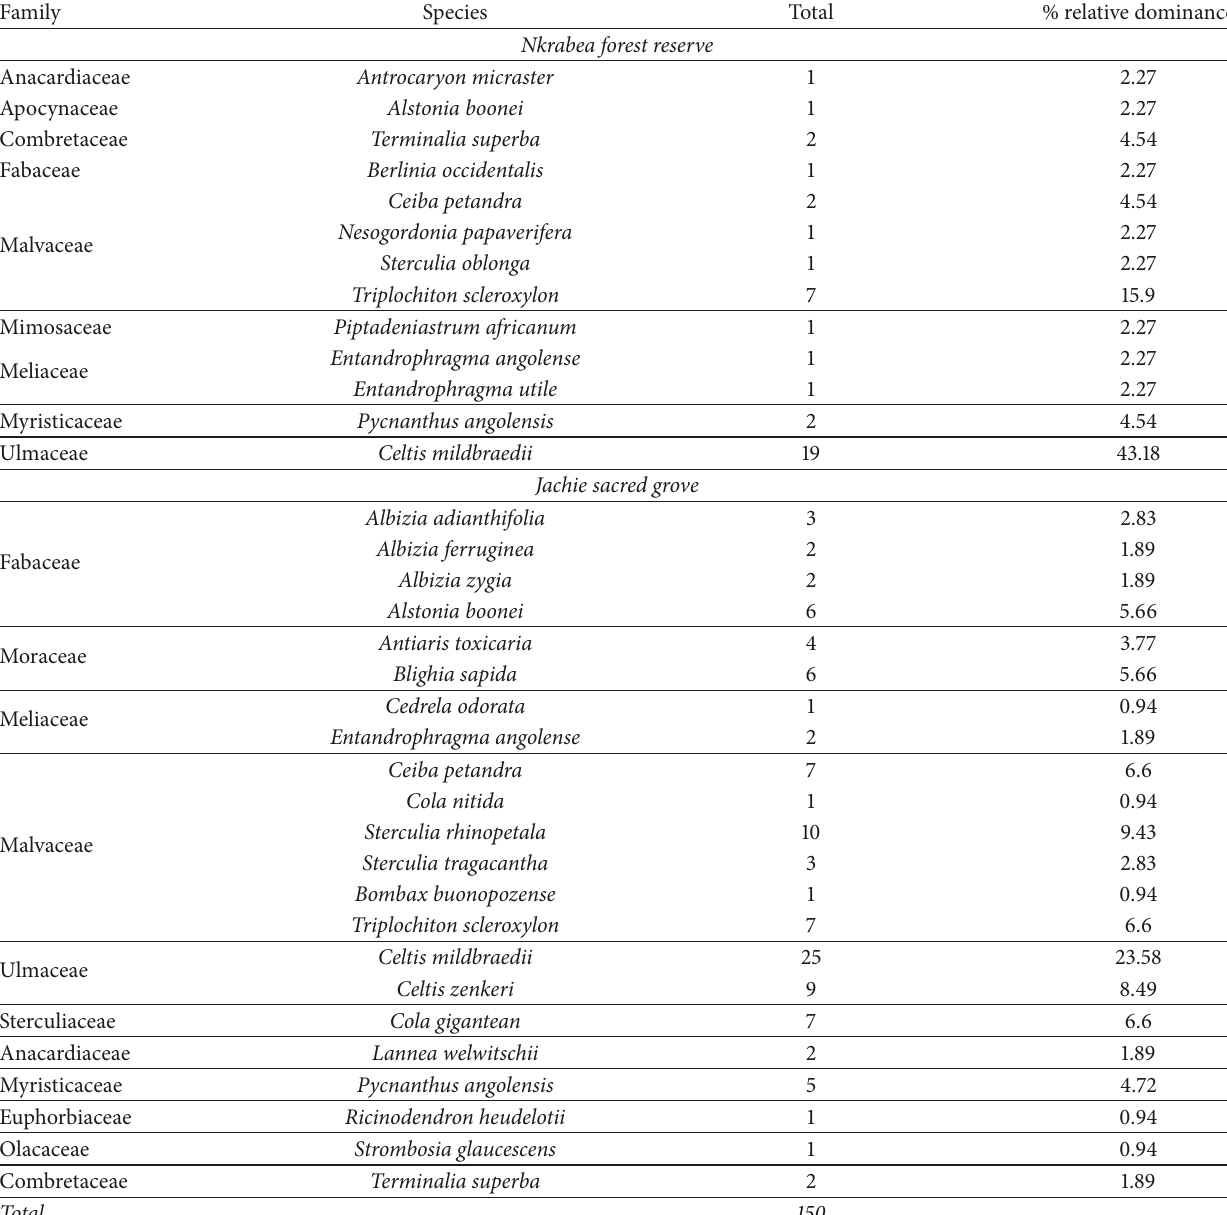
Table 1: A checklist of plant species and their relative abundance in Nkrabea forest